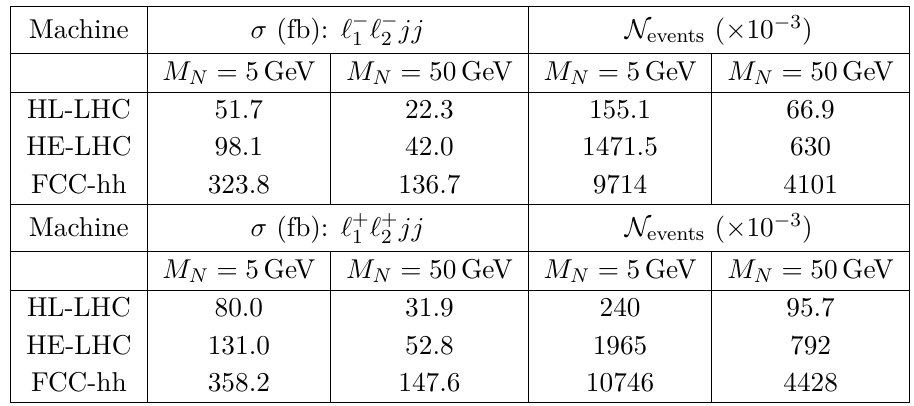
Predicted cross sections and number of events for pp → X‘ − X‘ + ‘ + (¯ q 0 q ) − . Neutrino masses M N = 5 and 50 GeV are considered. Results are given for the 1 2 √ HL-LHC ( s = 14 TeV, peak L int = 3 ab − 1 ), HE-LHC ( √ FCC-hh ( s = 100 TeV, peak L int = 30 ab − 1